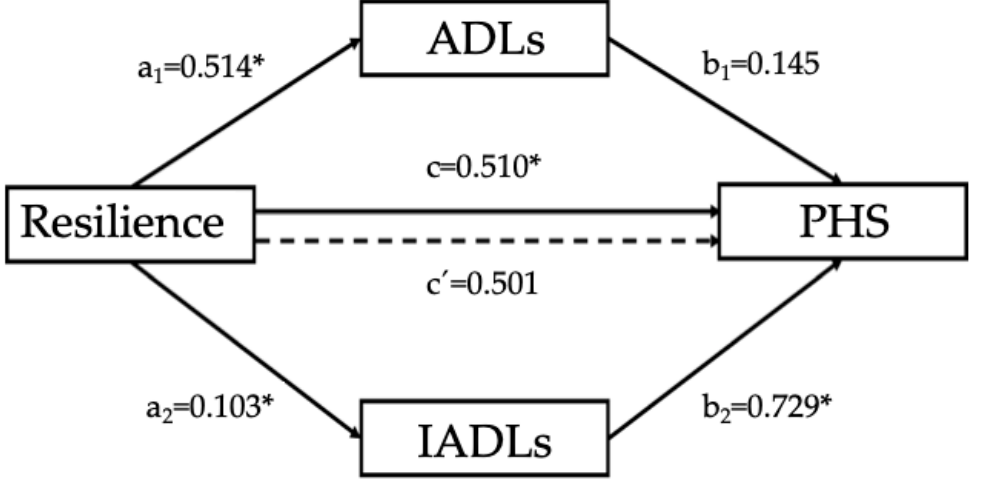
Figure 2. Representation of the relationships between the predicting variable, resilience, the mediator variables, ADLs and IADLs, and the criterion variable, PCS. The numerical values correspond to the unstandardized regression coefficients (* p < 0.05).